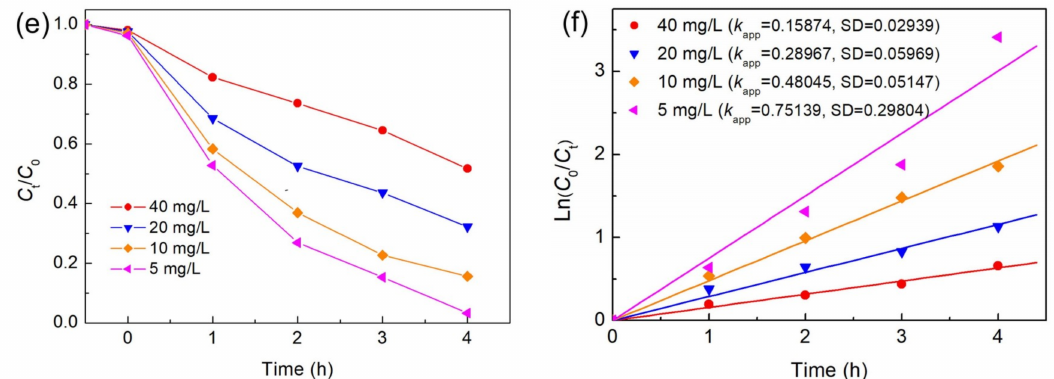
Figure 8. Effects of the photocatalyst (15% Ag 2 S/BiFeO 3 ) dosage ( a ) and ( b ), H 2 O 2 content ( c ) and ( d ), and MO concentration ( e ) and ( f ) on the photo-Fenton catalytic degradation of MO,